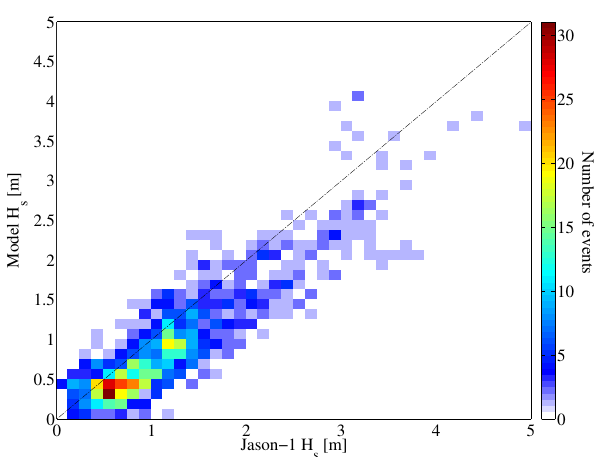
Figure 5. Comparison of the significant wave height evaluated by the SWAN model and by Jason 1 satellite